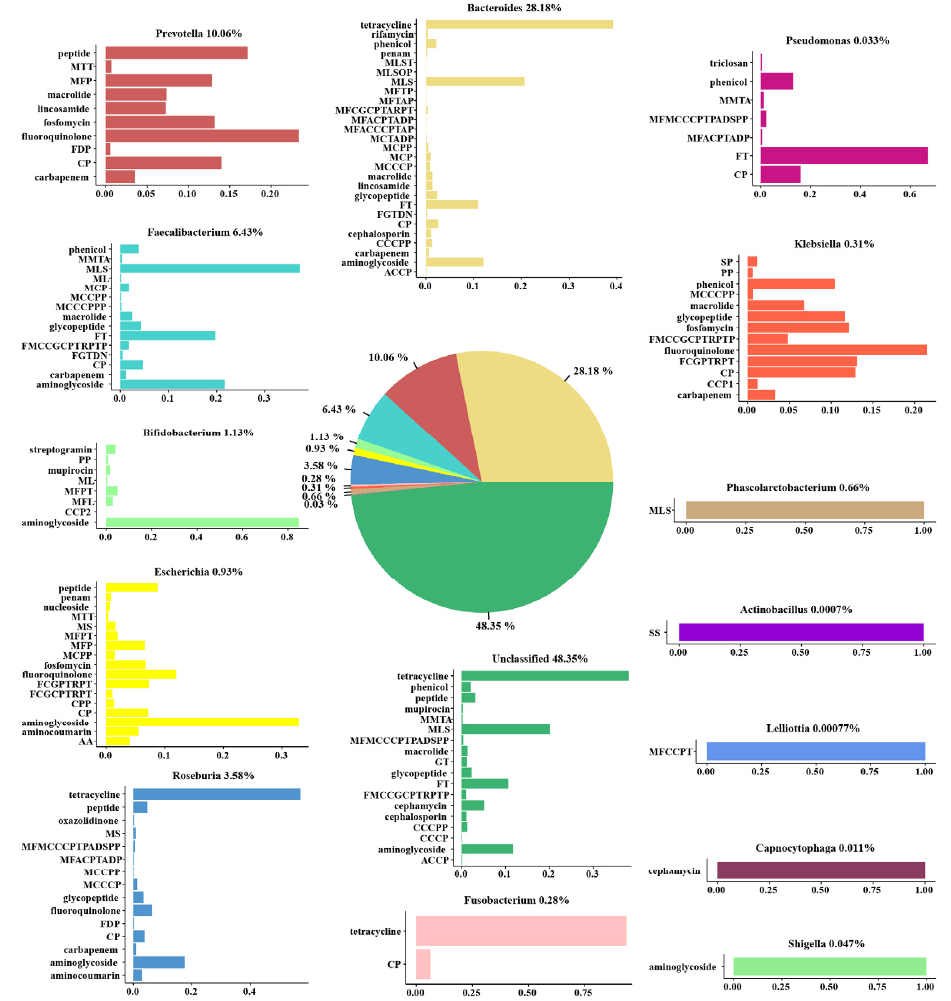
Figure 5. Major contributors to ARG. The pie chart represents the proportion of intestinal flora rich in ARG. The histograms represent the distribution of antibiotic resistance types in different bacterial genera.